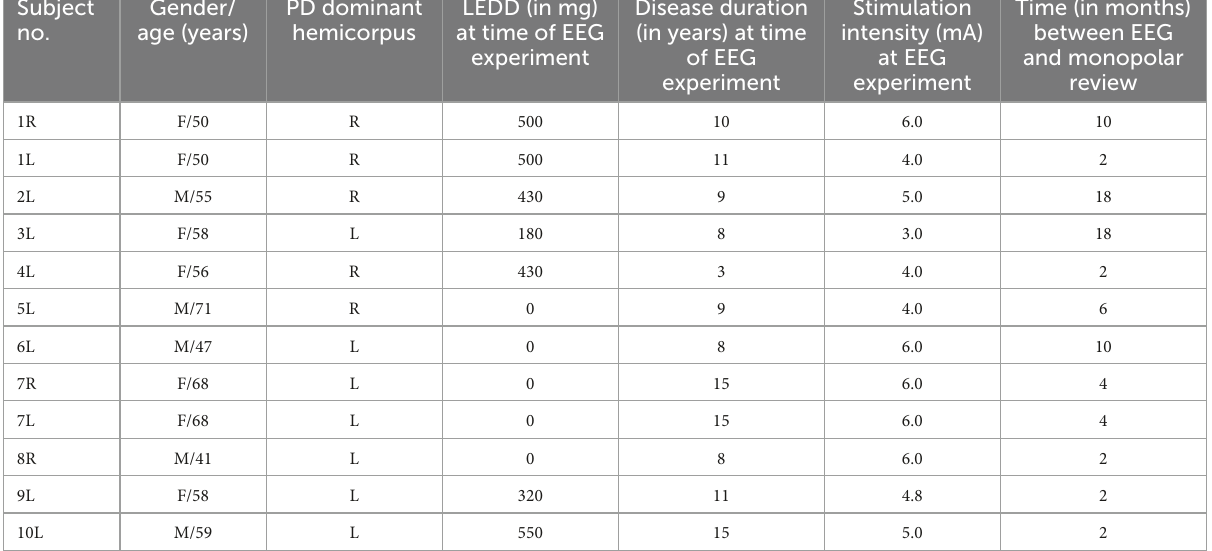
TABLE 1 Demographic data and stimulation